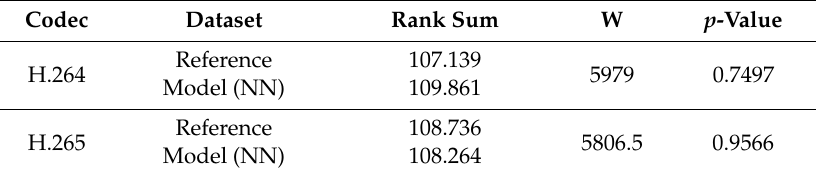
Table 2. Results of the Mann–Whitney–Wilcoxon